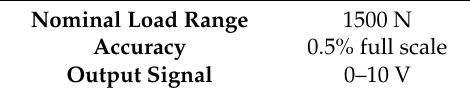
Table 3. Technical data of the HKM-Messtechnik force sensor pedal.